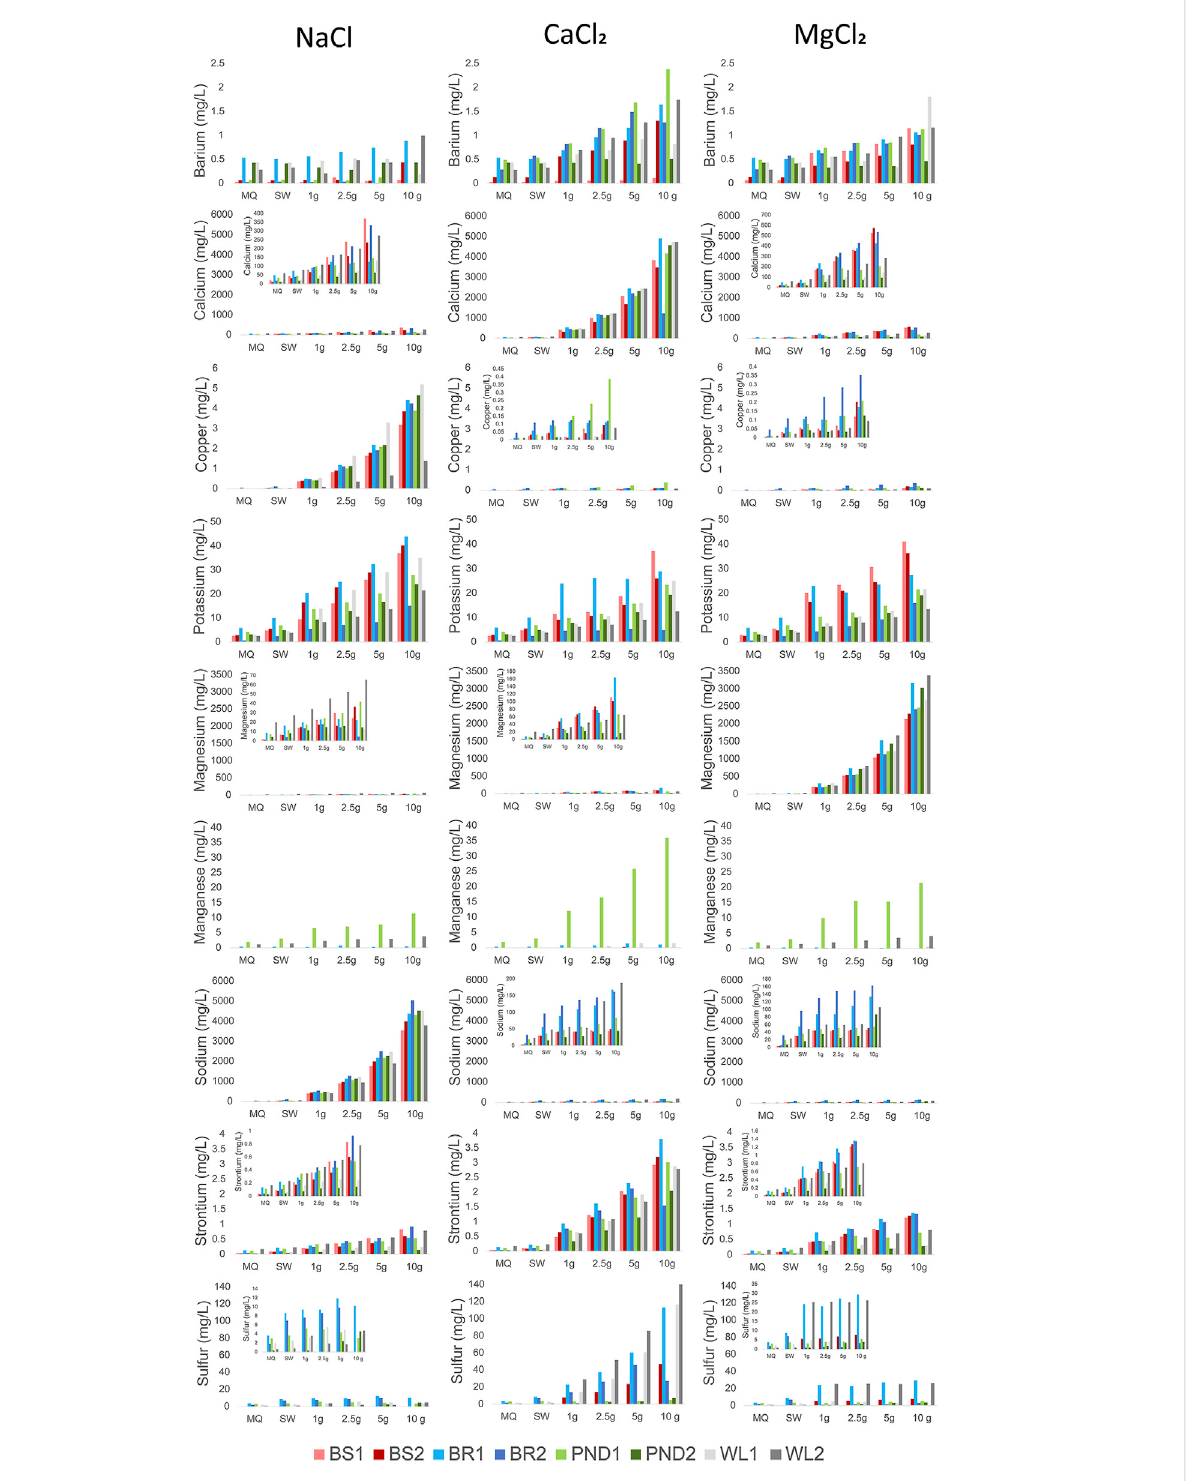
FIGURE 3 Elements mobilized by salt type and concentration. Scales are matching between salt types to better illustrate changes in mobilization by salt type. Inserts in the upper left corner of select graphs better show mobilization in otherwise fl attened curves. For visual clarity, the X axis is plotted as a function ofdiscretesalttreatment levelsandnotcontinuousconcentrationsproducing whatappeartobecurvilineartrendlines, however,relationships